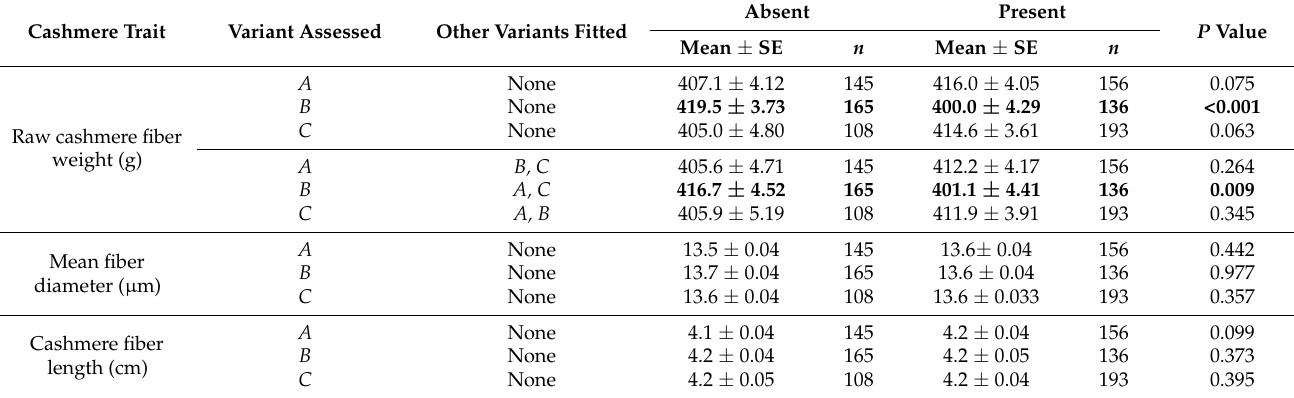
Table 1. Associations between caprine KRTAP1-2 sequences and cashmere fiber traits (Mean ± SE) 1 . Cashmere Trait Variant Assessed